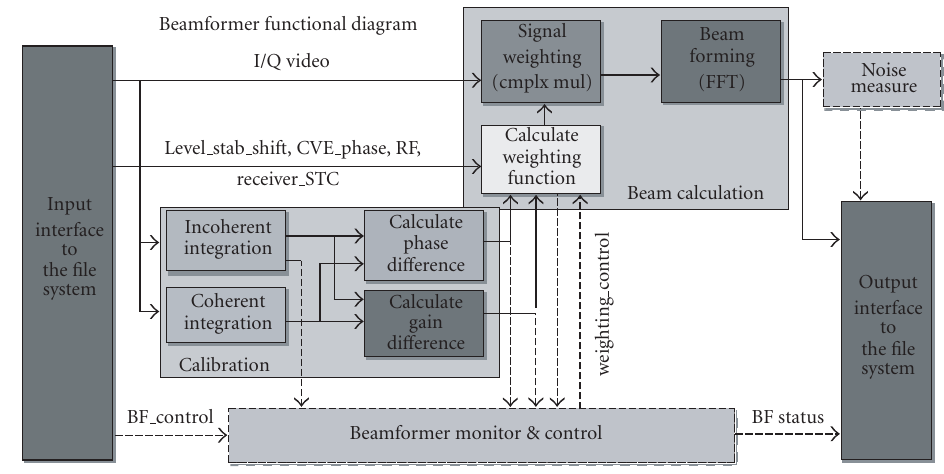
Figure 6: Radar functional processing